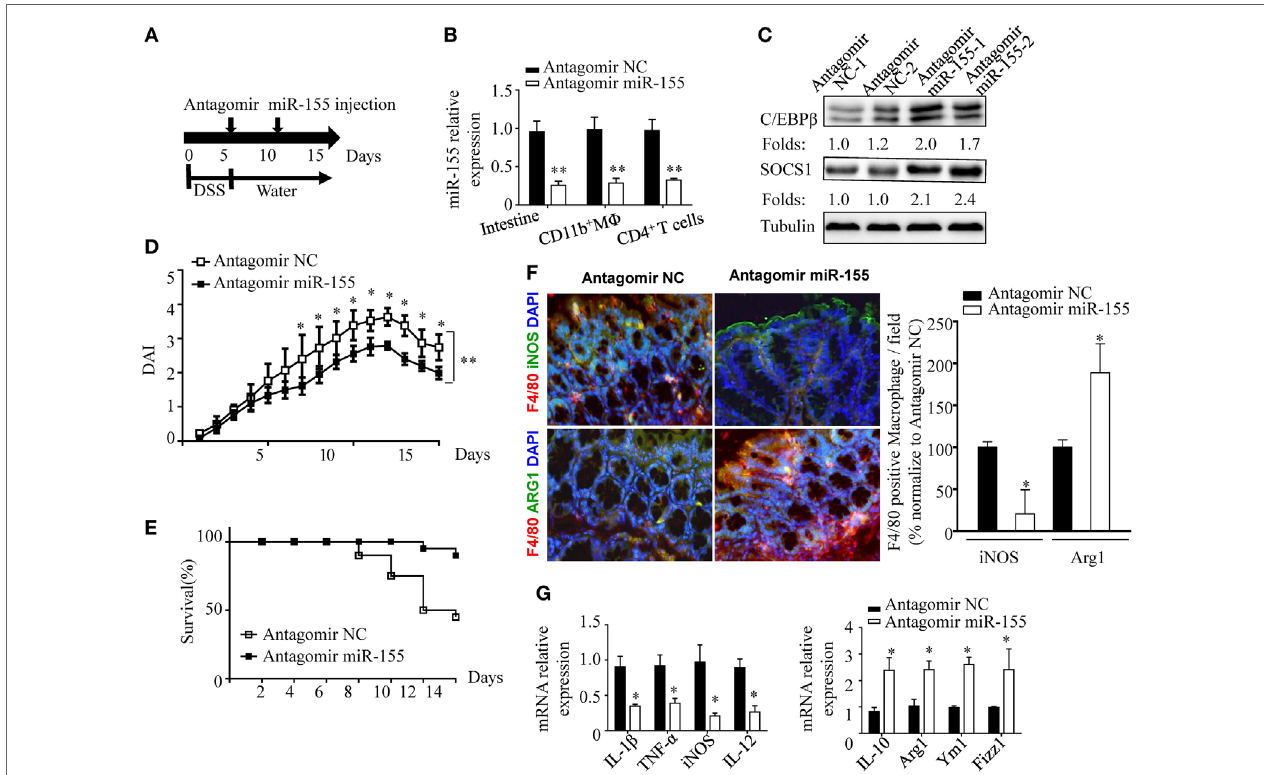
FigUre 7 | miR-155 antagomir treatment ameliorates dextran sulfate sodium (DSS) colitis pathogenesis and the proposed mechanism. (a–c) WT mice with DSS colitis were administered i.v. antagomir-155 (5 mmol/kg per mouse) or scrambled controls as the schematic protocol indicated, and miR-155 expression level and its functional targets C/EBP β and SOCS1 were determined by Q-PCR and western blotting respectively. (D,e) The DAI (e) and survival rate (e) of WT mice with DSS colitis that were treated with antagomir-155 or of NC mice were monitored daily till day 15 after DSS challenge. (F) The representative immunofluorescence images (left) and the quantification (right) of M1 and M2 in colon tissues co-stained with macrophage F4/80 (green), iNOS/Arg1 (red), and DAPI (nuclei, blue). (g) The relative expression of M1 genes and M2 genes in colon of antagomir-155 treated mice at day 15. * P < 0.05, vs antagomir-treated NC (Student’s t -test in (B,D,g) ]; n = 4–5 per group. Data are representative of two independent experiments (mean and SD). NC, negative control; WT,